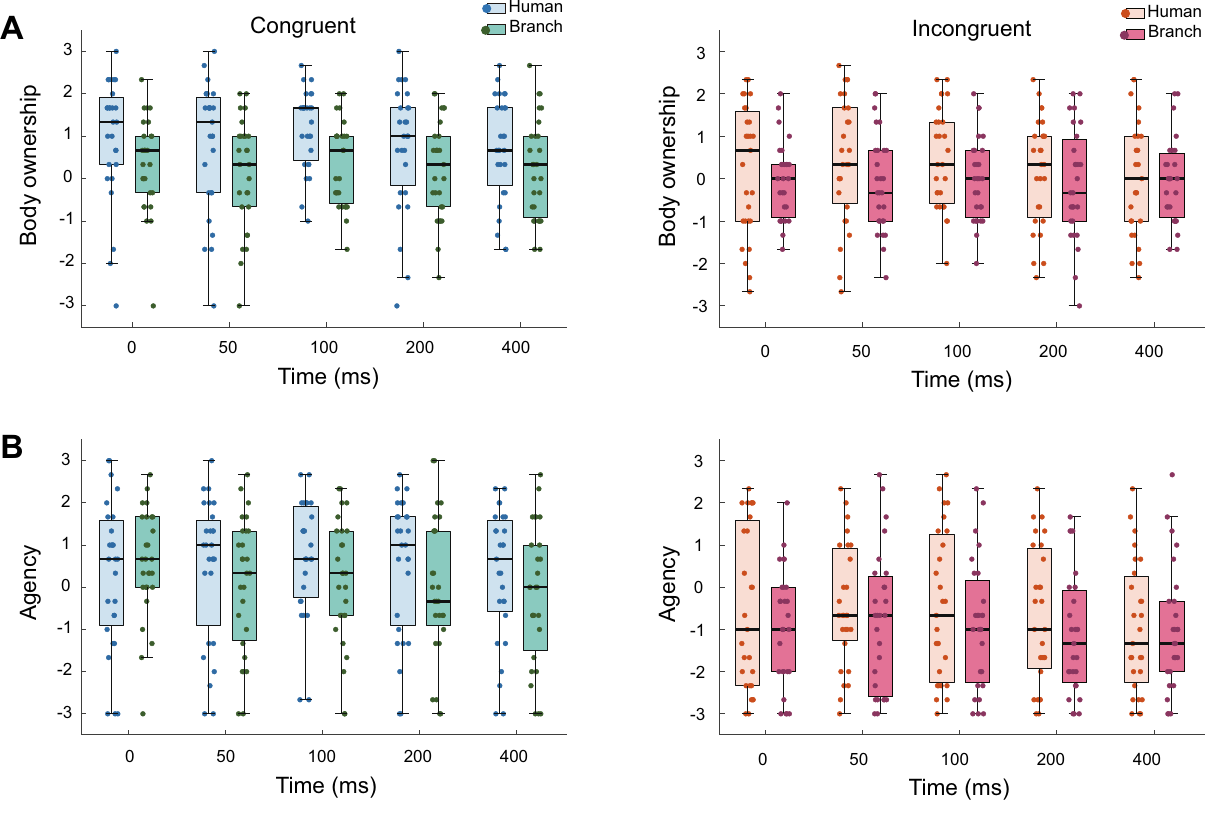
Figure 2. Boxplots for body ownership ( A ) and sense of agency ( B